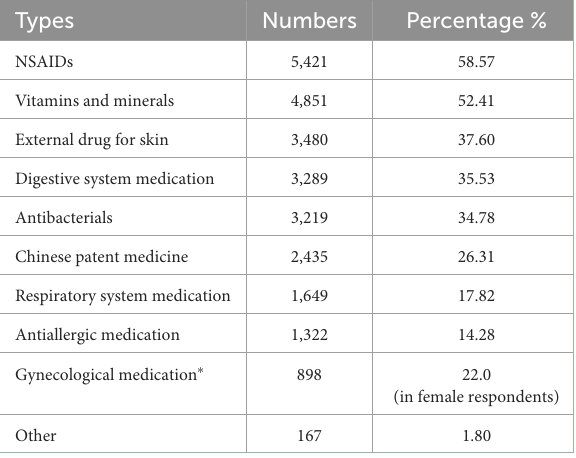
TABLE 2 Types and proportion of OTC drugs purchased and used by